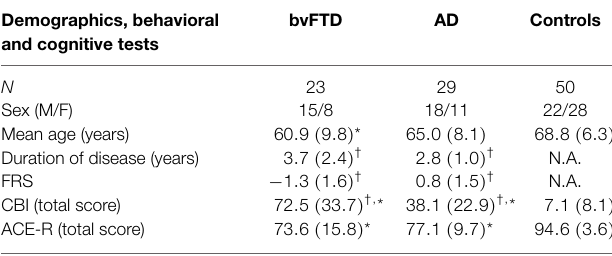
Demographics, behavioral and cognitive